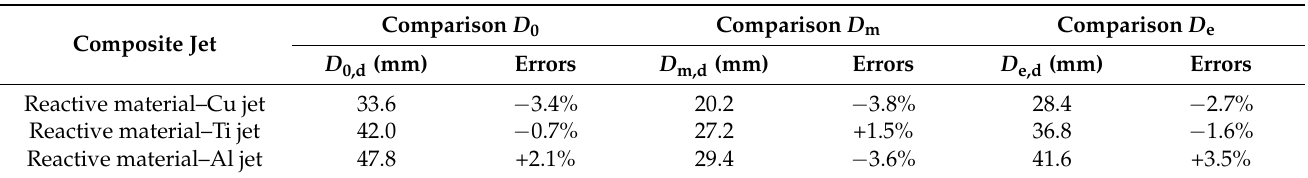
Figure 18. Combined perforation effects of composite jets against steel targets after the detonation- like reaction of reactive materials: ( a ) reactive material–Cu jet; ( b ) reactive material–Ti jet; ( c ) reactive material–Al jet. Table 8. Comparison between experimental results and numerical penetration hole diameters after the detonation-like reaction of reactive materials.